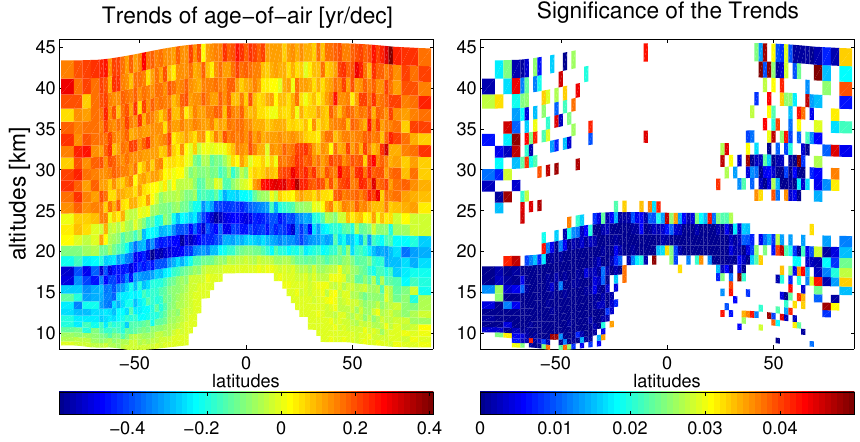
Fig. 13. (Left): altitude-latitude cross-sections of the age trend derived from linear regression over the 22 yr of available data. (Right): p -value of its associated Student statistical test of significance where the p -value is less than 0.05.